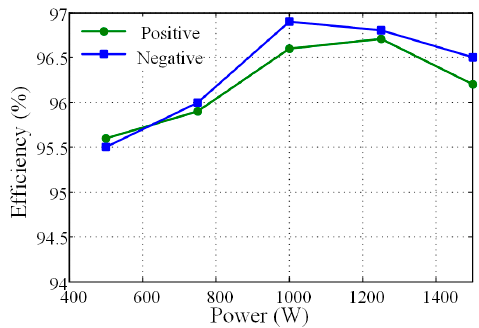
Figure 19. Waveforms of resonant currents of three ports and transformer port voltages.